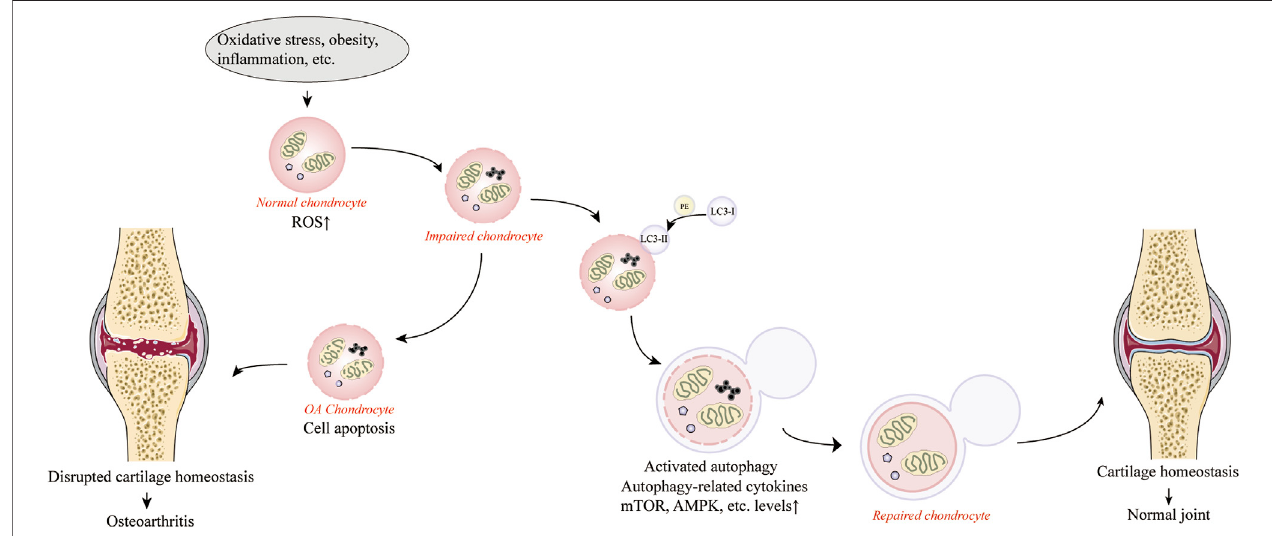
FIGURE 1 | Activation of autophagy against osteoarthritis by maintaining cartilage homeostasis. Produced using Servier Medical Art (smart.servier.com).